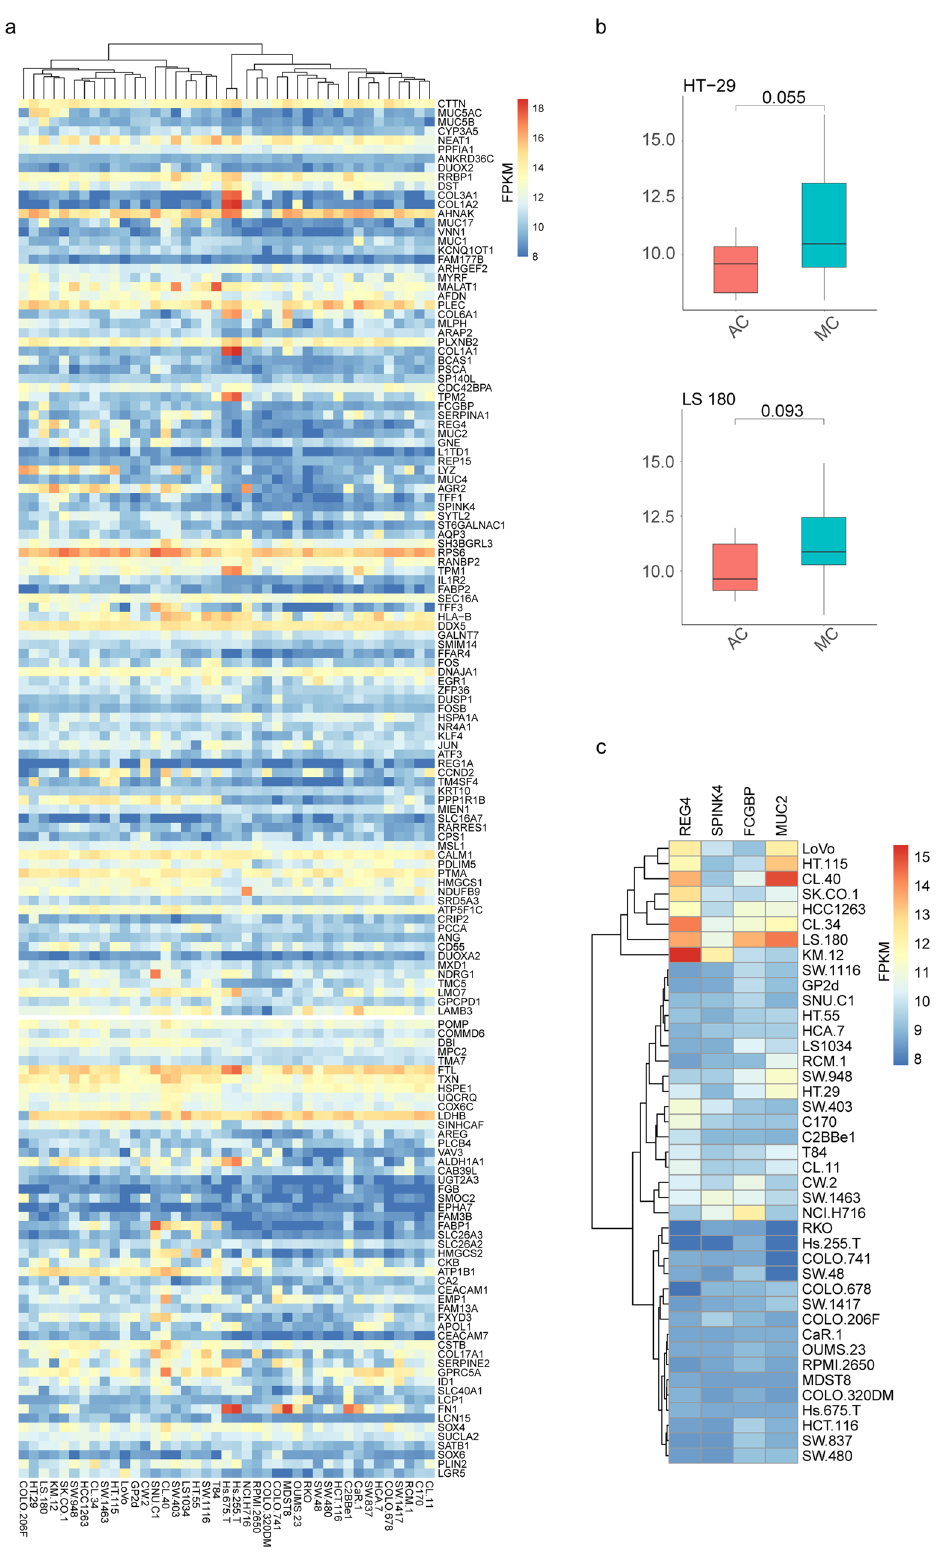
Fig. 6 Phenotypic predisposition to mucinous adenocarcinoma in 41 cell lines. a Hierarchical clustering heatmap of the expression of MC and AC module genes in 41 cell lines. b Boxplots of the differential expression of MC and AC module genes in HT-29 and LS 180 cell lines. The lower hinge, middle line, and upper hinger of boxplots represented the fi rst, second, and third quartiles of the distributions. The upper and lower whiskers corresponded to the largest and smallest data points within the 1.5 interquartile range. c Hierarchical clustering heatmap of the expression of goblet marker genes in 41 cell lines. All colour keys from blue to red represent the FPKM levels from low to